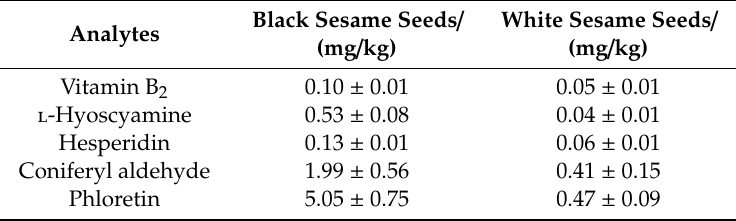
Figure 2. Volcano plot of ten targets in white and black sesames. Table 4. Content of 5 differential nutrients in sesame seeds.